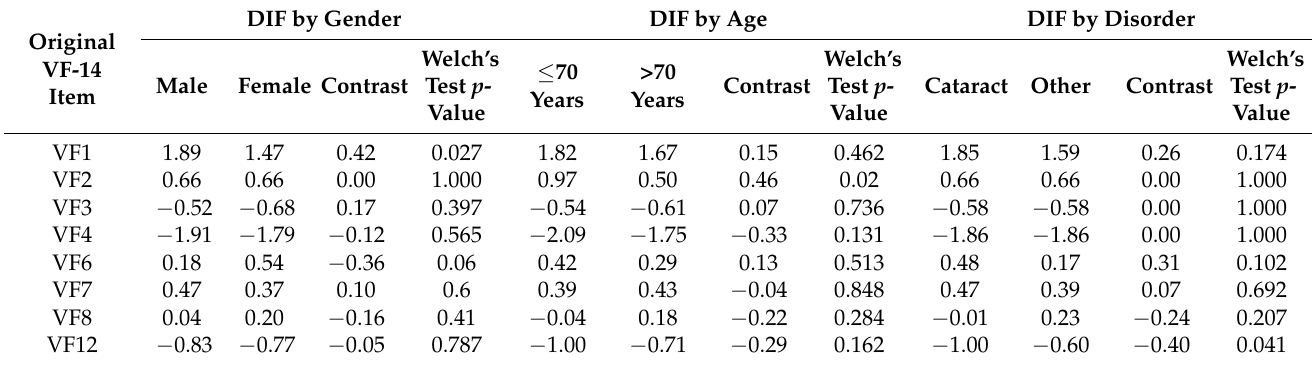
Table 3. Differential Item Functioning (DIF) by Gender, age, and